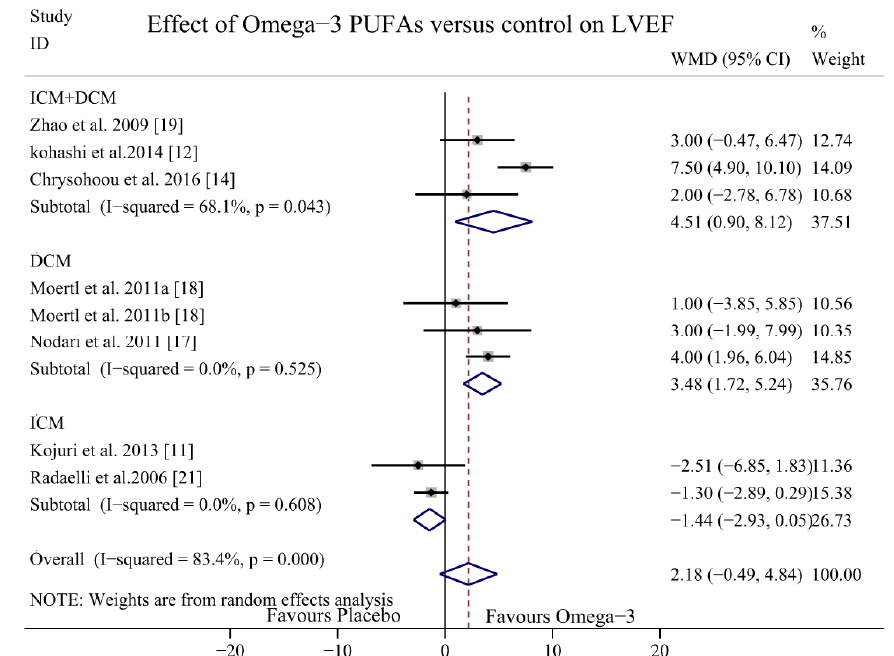
Figure 6. Forest plot depicting the subgroup analysis of the effect of omega ‐ 3 PUFAs on LVEF (WMD, weighted mean difference). Abbreviations: LVEF, left ventricular ejection fraction; PUFAs, polyunsaturated fatty acids.